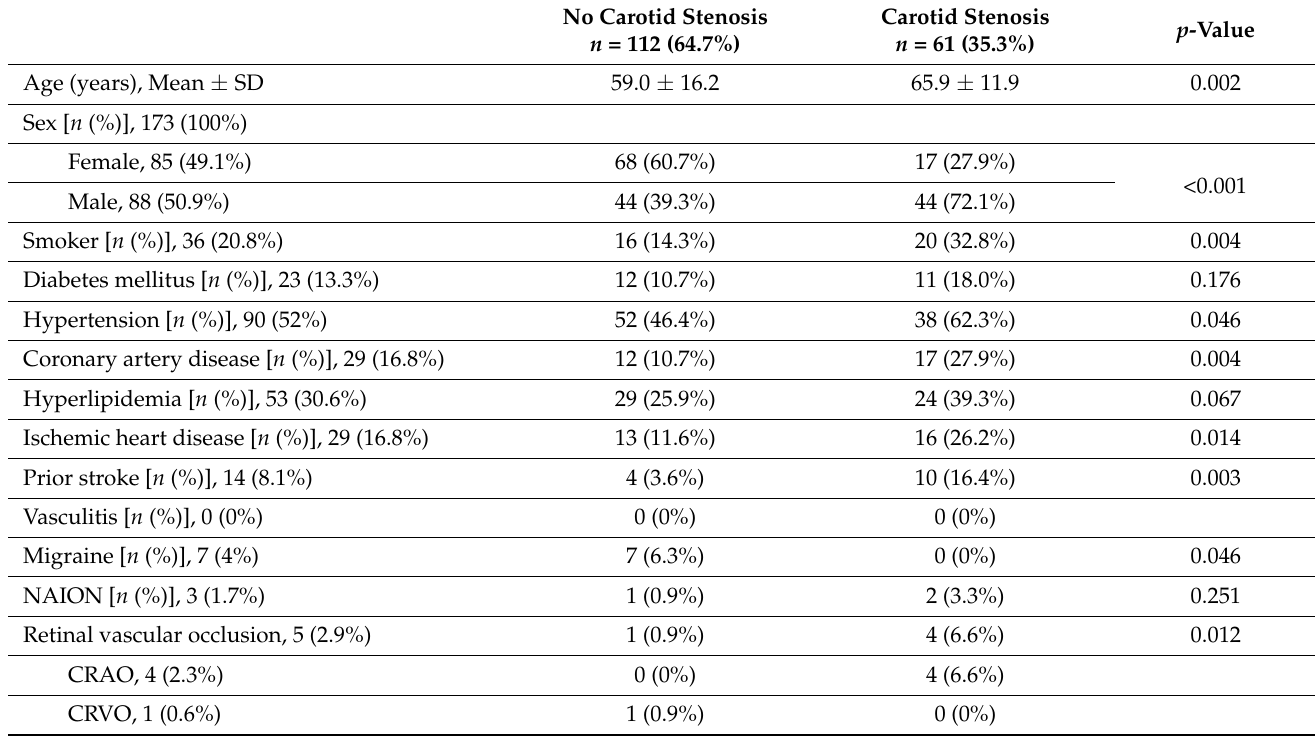
Table 1. Demographic data on patients with AF ( n =